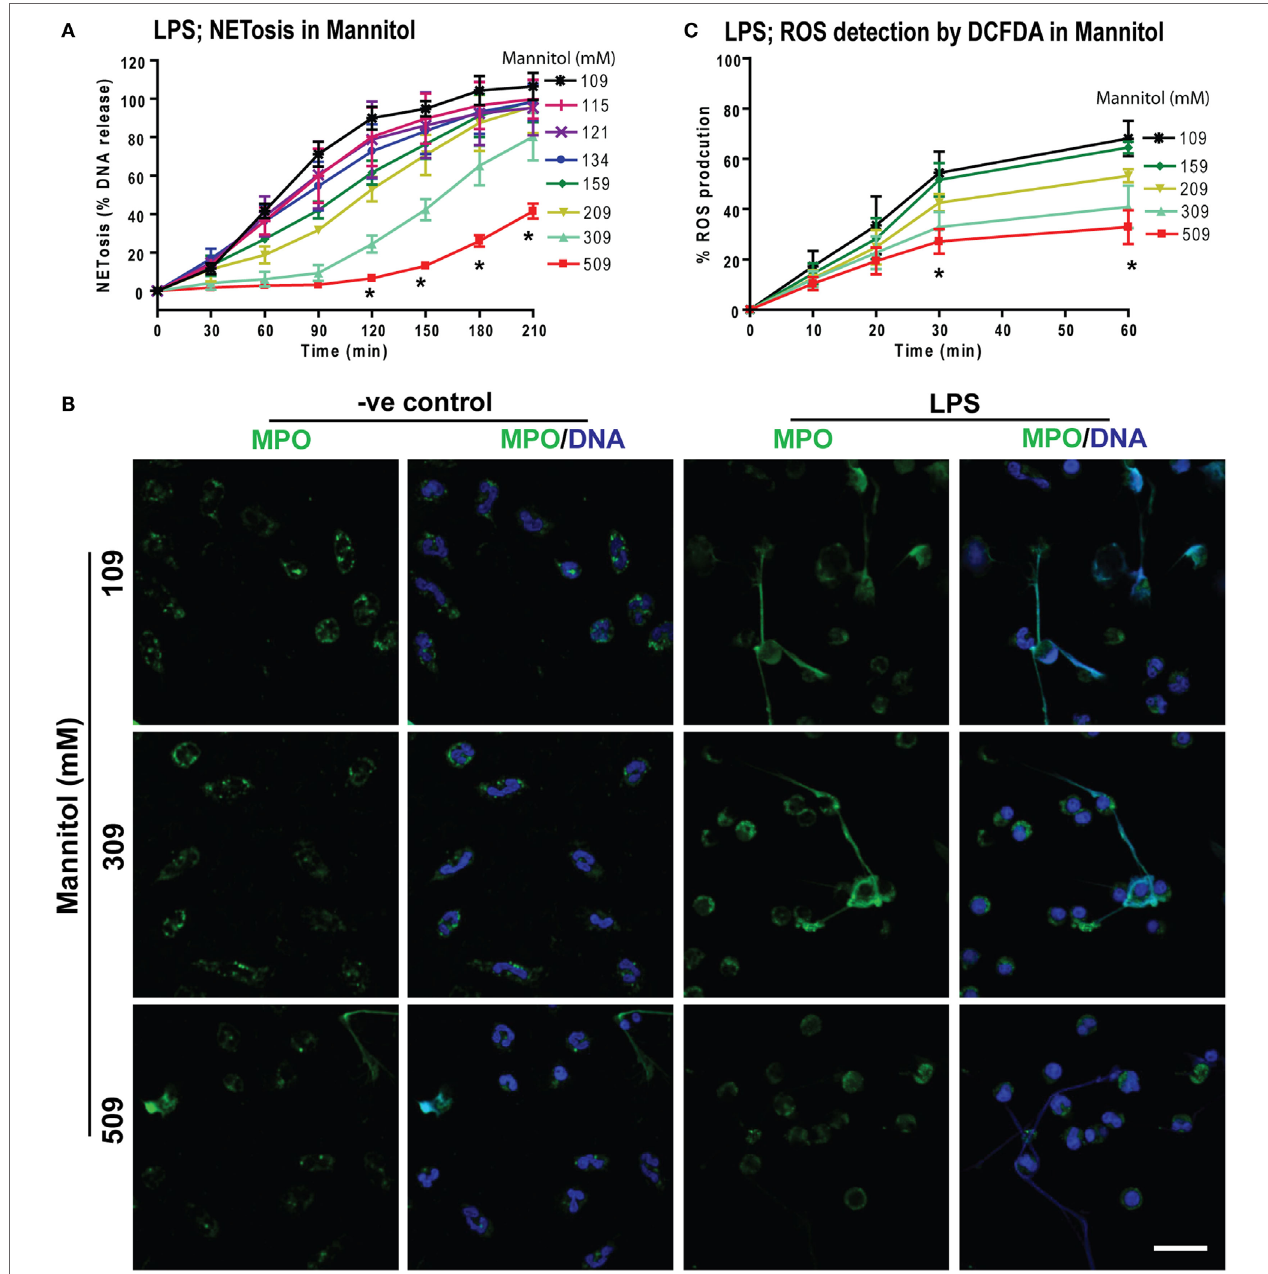
FigUre 6 | Increasing concentrations of d -mannitol suppress lipopolysaccharide (LPS)-mediated reactive oxygen species (ROS) production and NETosis. (a) The % DNA release NETosis kinetics shows the suppression of LPS-mediated NETosis in increasing concentrations of d -mannitol ( n = 3; * p < 0.05; two-way ANOVA with Bonferroni’s multiple comparison post test). (B) Myeloperoxidase-immunostained and confocal images of unstimulated neutrophils ( − ve control) and LPS-treated cells in different concentrations of d -mannitol shows the suppression of NETosis at higher concentration ( n = 3; MPO-green; DNA-DAPI; scale bar, 22 µm). (c) LPS-induced ROS production measured by DCFDA in neutrophils under different d -mannitol concentrations, show the ROS suppression at high d -mannitol concentrations over 60 min ( n = 3; * p < 0.05; two-way ANOVA with Bonferroni’s multiple comparison post test). See Figures S5 and S6 in Supplementary Material for d -sorbitol NETosis and ROS production